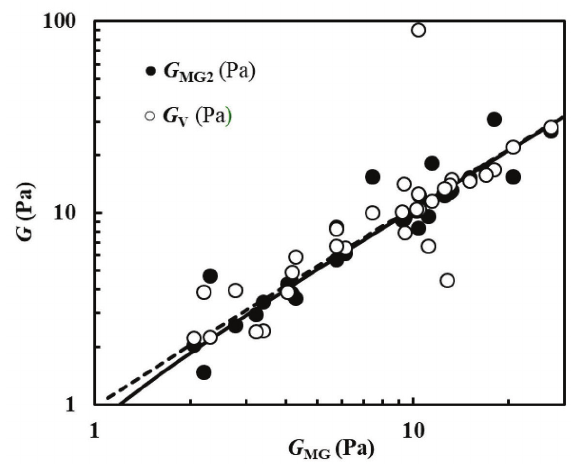
Fig. 2 – Dependence of the samples shear modulus evaluated according to the MG2 (closed circles; G ) and V (open cir- MG2 cles; G ) strategies on the shear modulus estimated according V to the MG approach (G ). Solid and dashed lines indicate the MG linear interpolants, according to a robust fitting approach, re- ferring to the (G vs G ) and the (G vs G ) trends. MG2 MG V MG